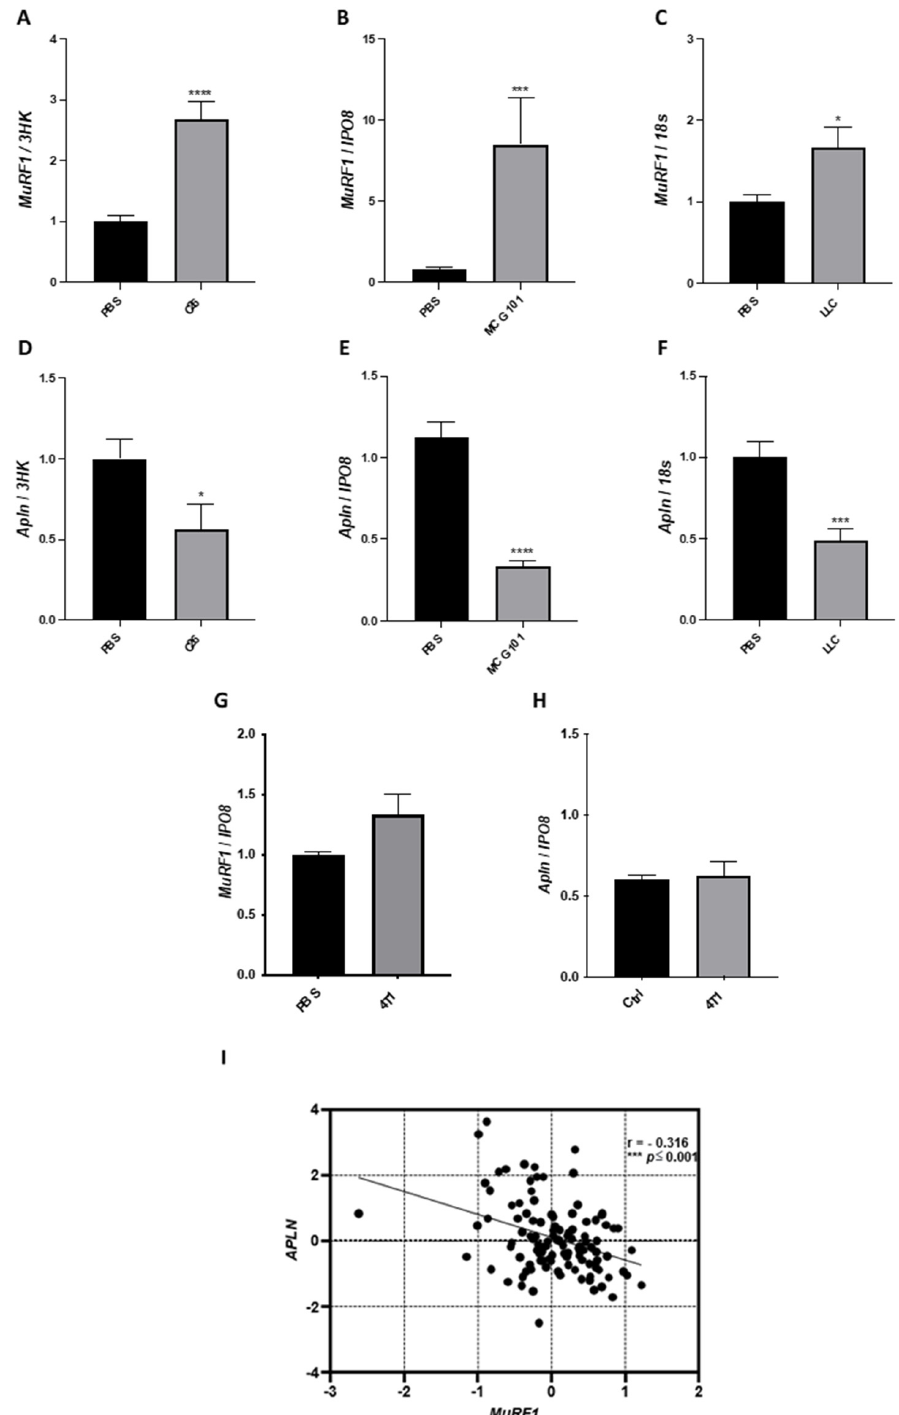
Figure 2. In the atrophied muscle of all the three animal models of cancer cachexia and cancer patients, apelin expression falls when MuRF1 increases. Q-PCR shows that mRNA levels of the ubiquitin ligase MuRF1 are highly induced in the TA of mice carrying the tumor C26 ( A ) or MCG101 ( B ) or LLC ( C ). Unpaired t -test, **** p ≤ 0.0001 ( A ); Mann–Whitney test, *** p ≤ 0.001 ( B ). Unpaired t -test, * p ≤ 0.05 ( C ), n = 7–10 ( A – C ). Apelin ( Apln ) expression is drastically decreased in TA from mice bearing C26 ( D ) or MCG101 ( E ) or LLC ( F ). Unpaired t -test, * p ≤ 0.05 ( D ), **** p ≤ 0.0001 ( E ), *** p ≤ 0.001 ( F ), n = 7–10. The mRNA levels of MuRF1 are not induced in the TA of mice carrying the non-cachectic tumor 4T1 ( G ) and apelin expression is not altered in this tumor model ( H ). 3HK, three housekeeping genes ( TBP , IPO8, and Gusb ), IPO8 or Importin 8 and 18S or 18S ribosomal RNA , were used to normalize the data. Unpaired t -test, not significant, n = 5. In rectus abdominis muscles from